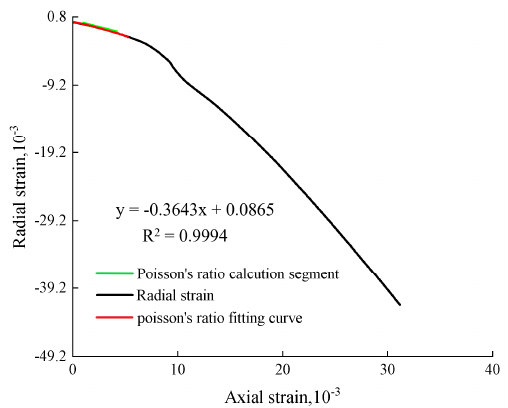
Figure 10. Variation curve of Poisson’s ratio of typical cores.